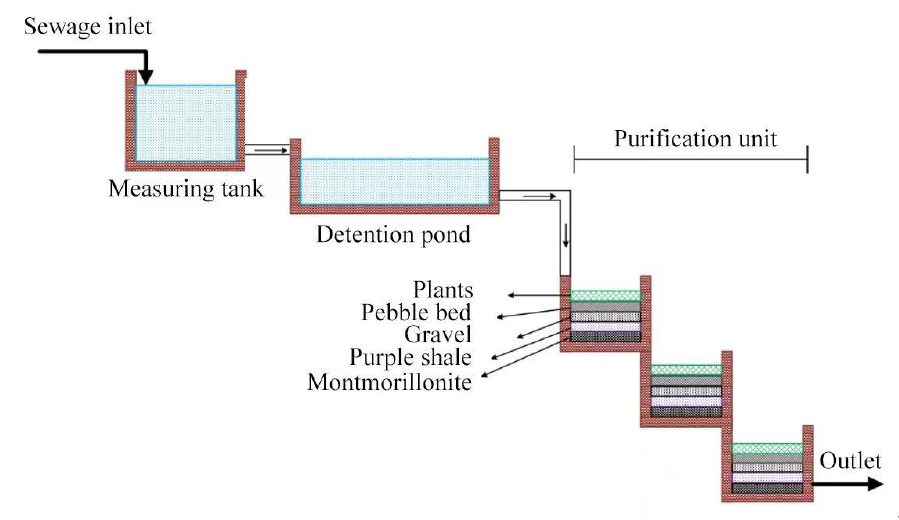
Figure 1. Flow chart of the sewage treatment of the tower-shaped integrated ecological purification device (TIEPD).